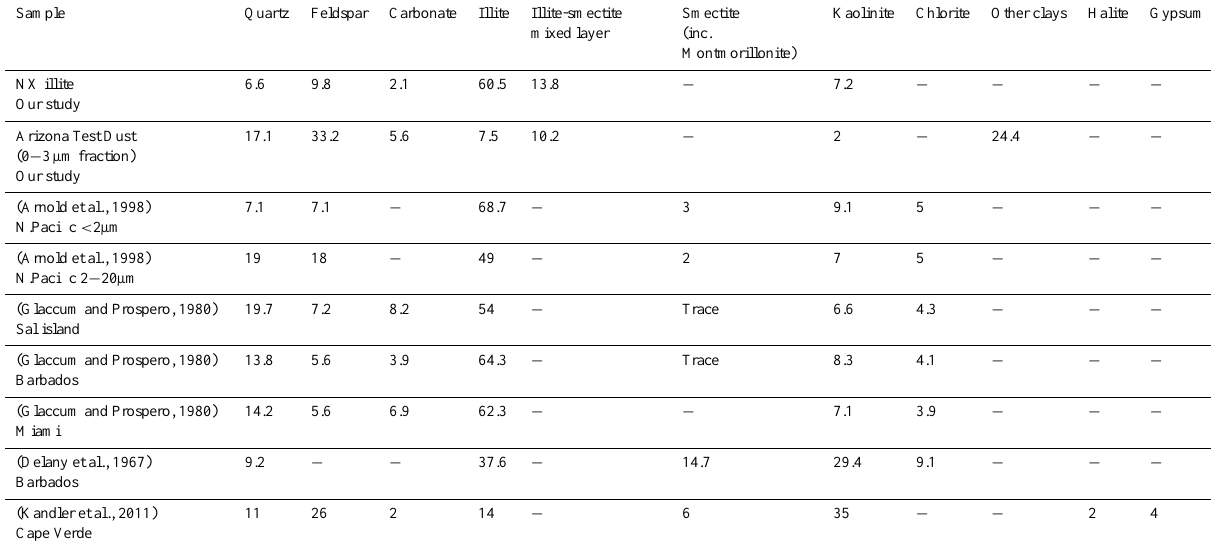
Table 1. Summary of mineralogical composition of NX illite, Arizona Test Dust and samples of airborne dust collected some distance from the source